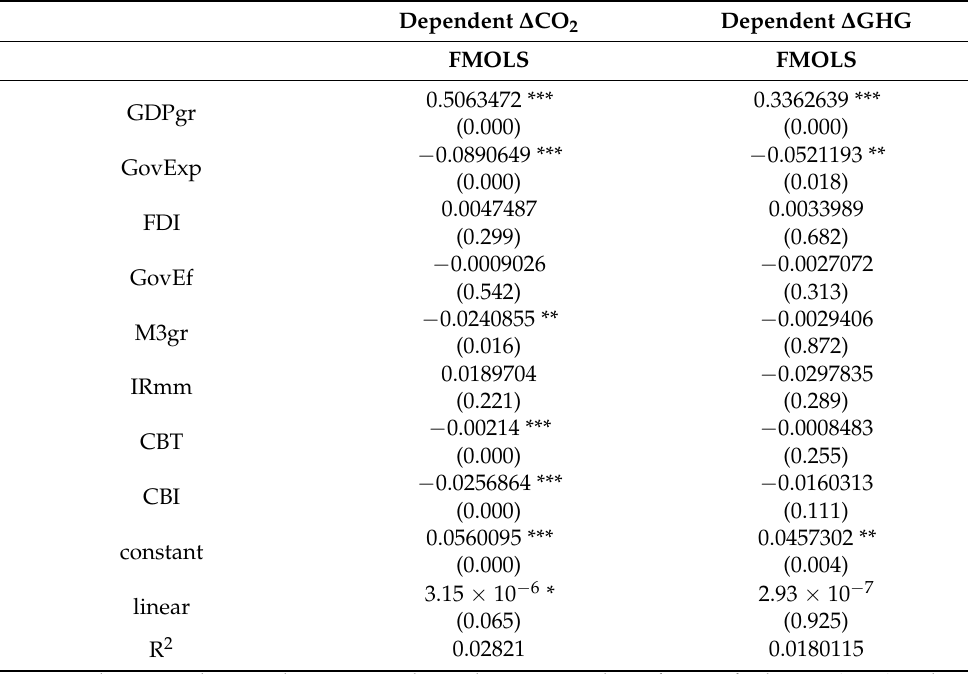
Table 8. All countries’ CO 2 and GHG emissions under